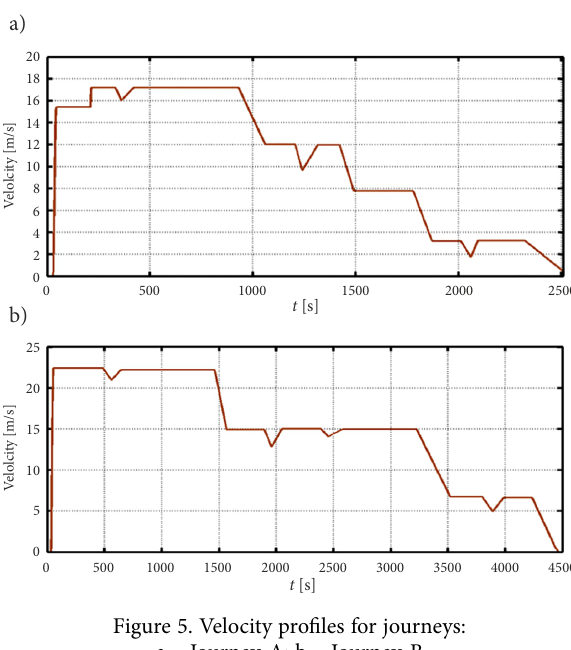
Figure 5. Velocity profiles for journeys: